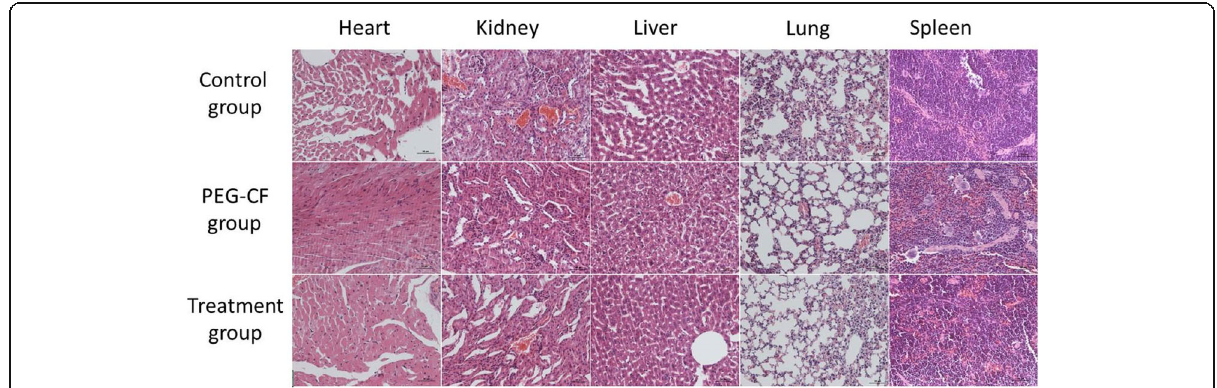
Fig. 10 Histology sections of tissues after exposure of PEG-CoFe 2 O 4 or curcumin to